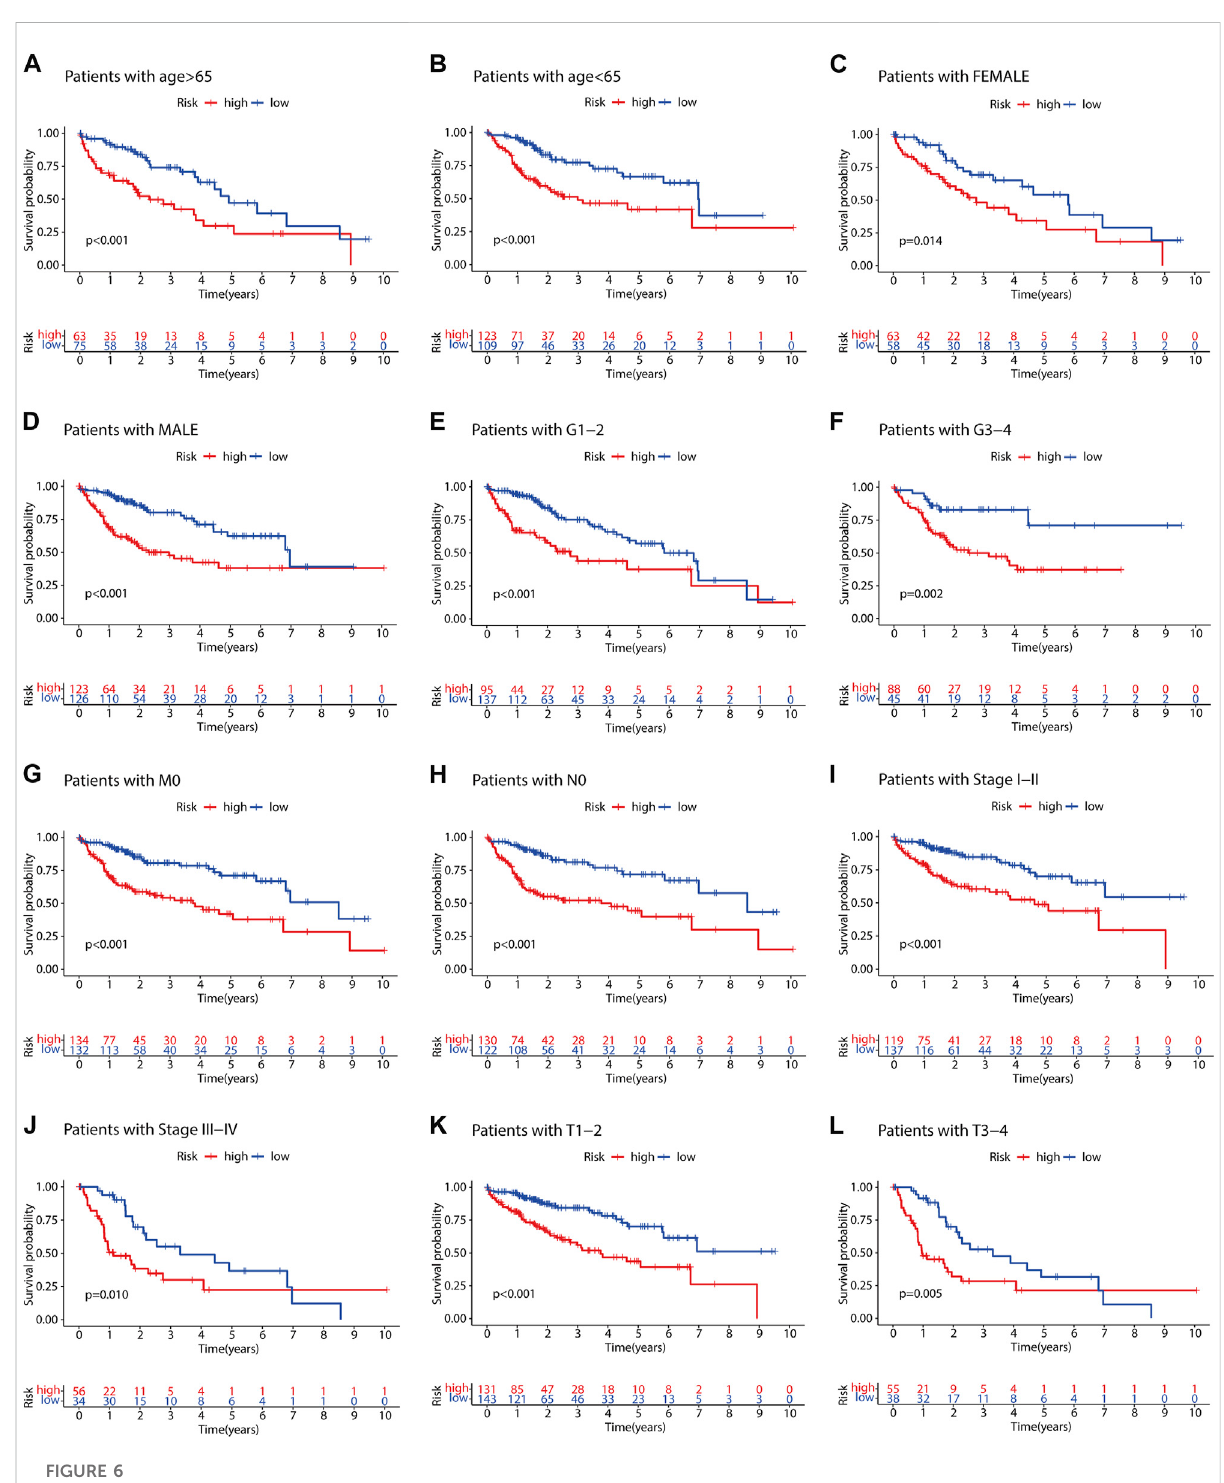
FIGURE 6 (A – L) Kaplan – Meier analyses of patients with AJCC-T, tumor grade, stage, gender, and